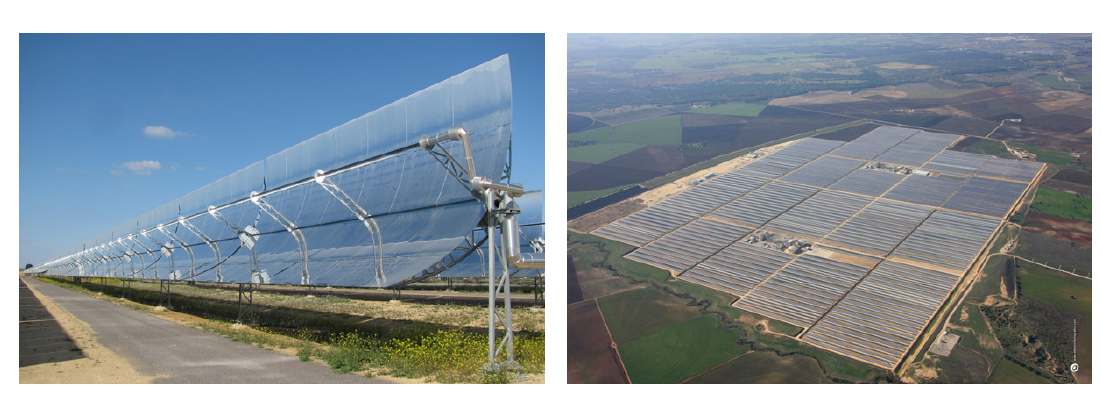
Figure 1. Valle 1 and 2 solar thermal power